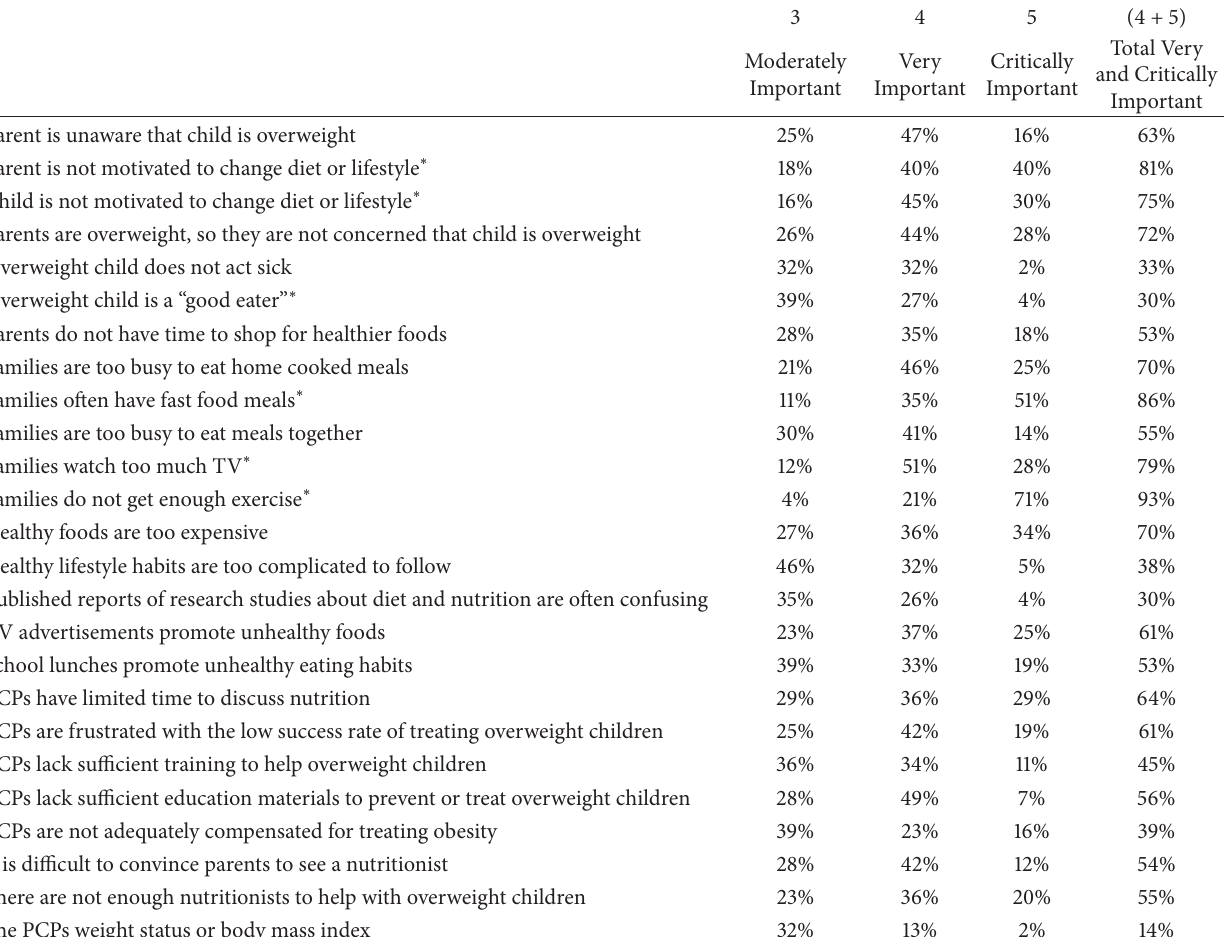
Table 1: Respondents’ perceptions of barriers to obesity prevention or treatment in primary care, expressed as the percentage of respondents providing affirmative responses to the statement: “Please rate the importance of each of the following general barriers to preventing or treating overweight or obesity in children in your professional experience” (on a scale of importance